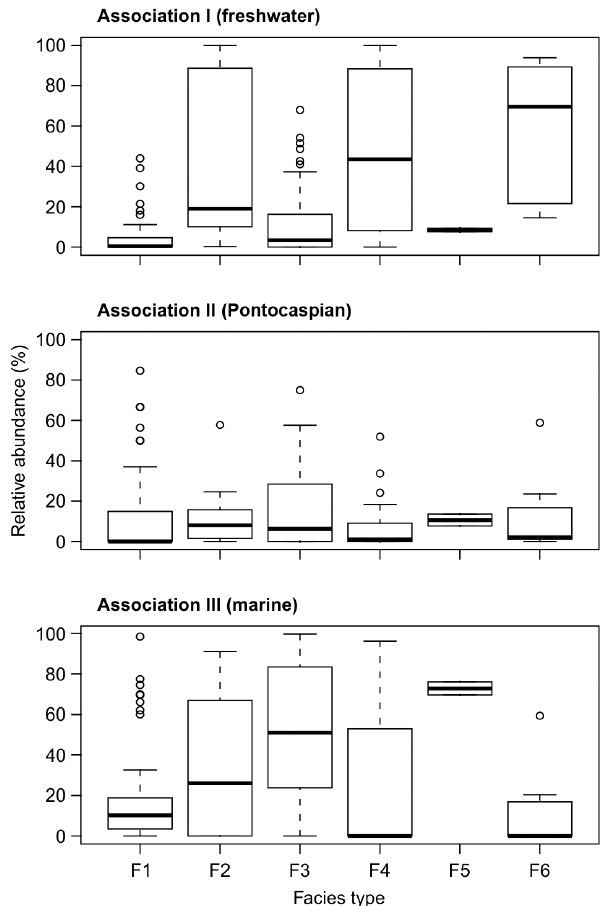
Figure 7. Box plots show the distribution of relative abundances of the associations across the six facies